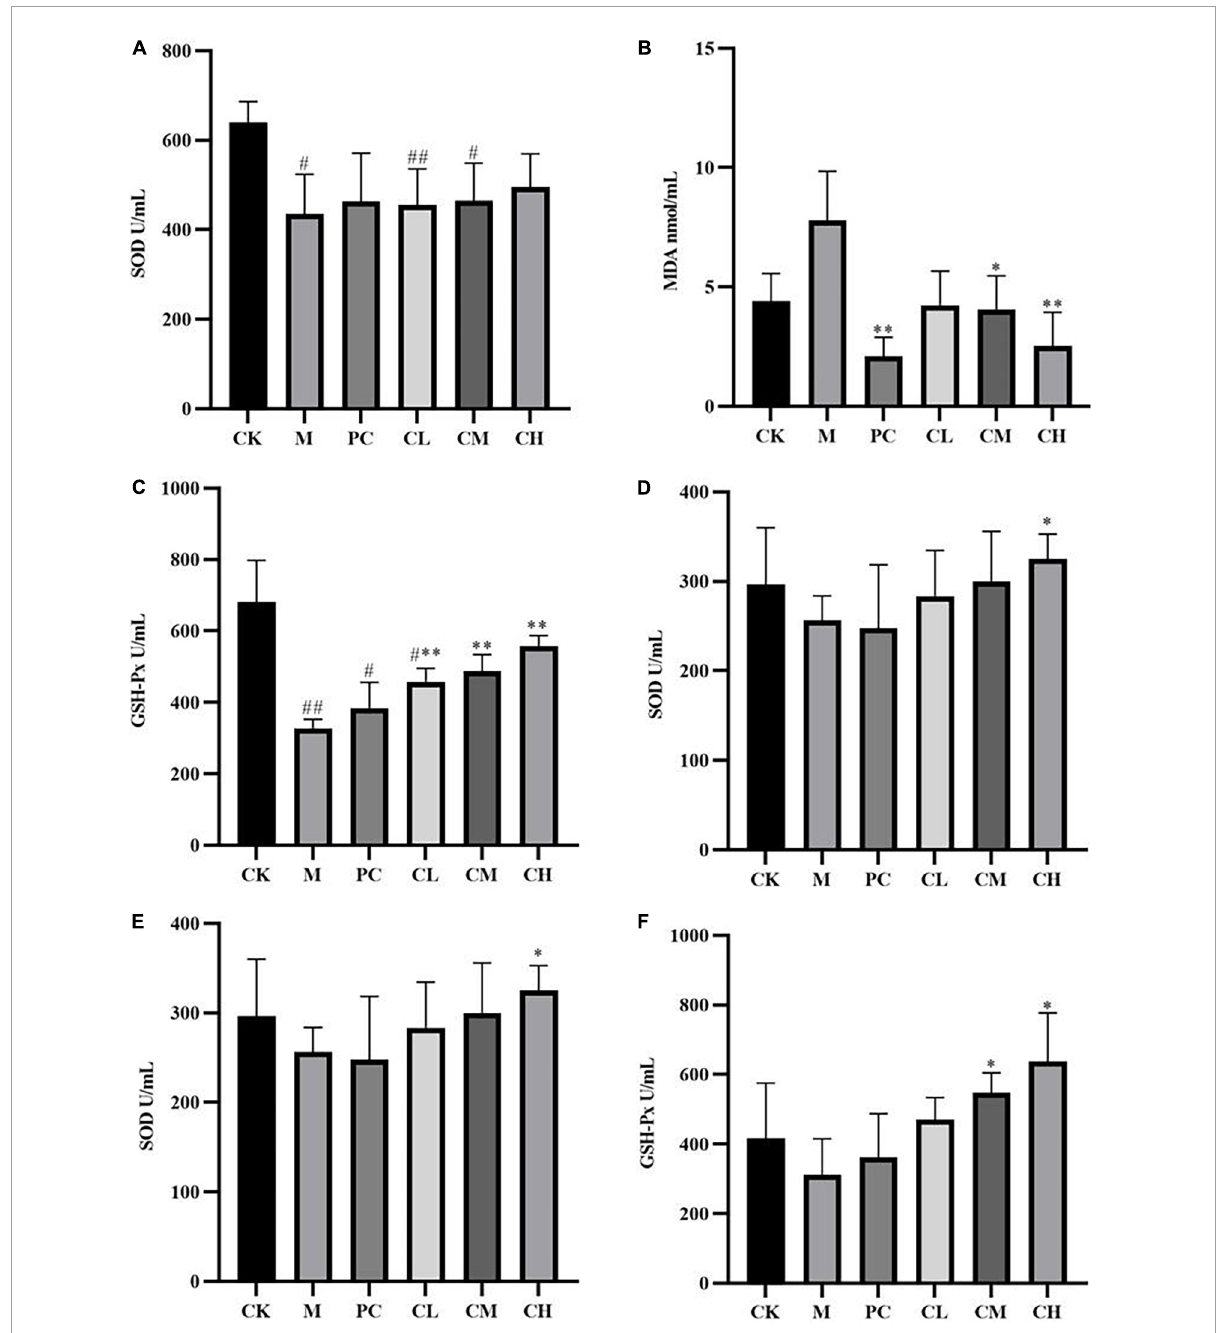
FIGURE4 Effects of samples on the levels of SOD (A) , MDA (B) , and GSH-Px (C) in liver tissues and SOD (D) , MDA (E) , and GSH-Px (F) in kidney tissues. (Compared with the M group, * indicates P < 0.05, ** indicates P < 0.01; compared with the CK group, # indicates P < 0.05, ## indicates P <